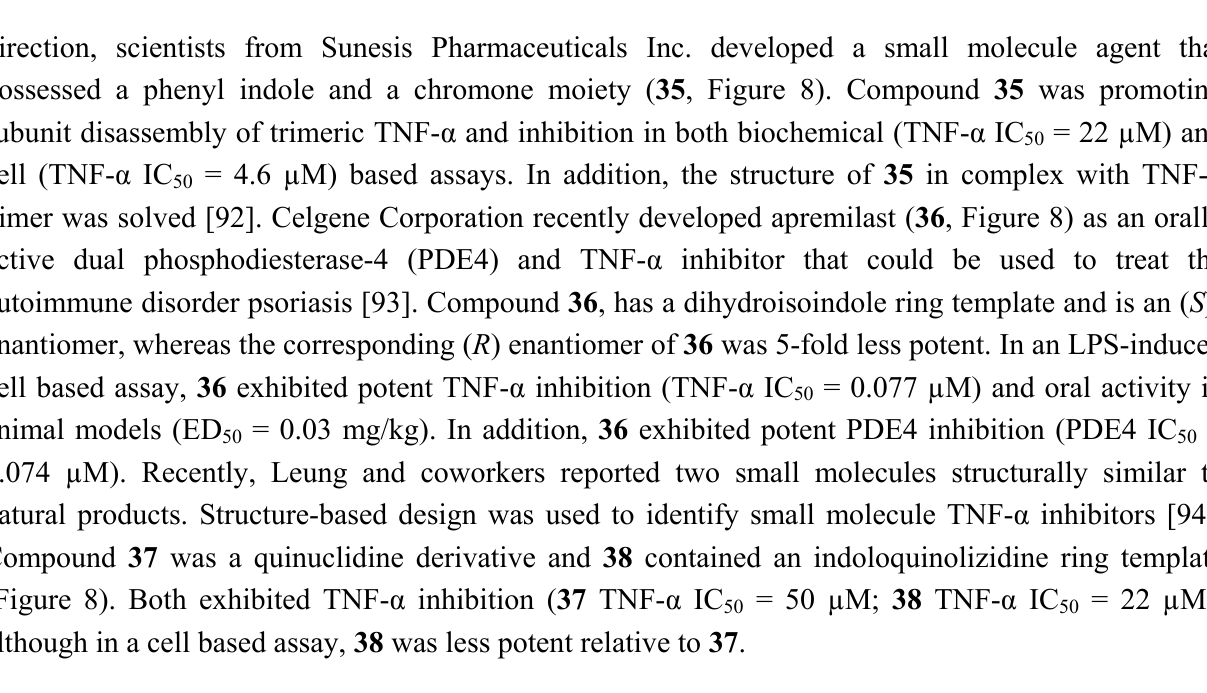
Figure 8. Examples of some representative TNF- α